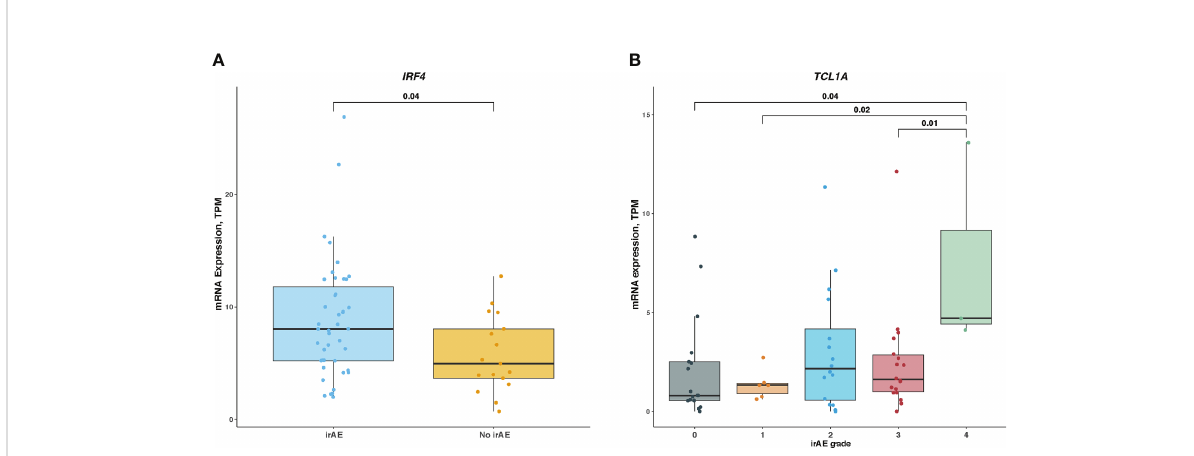
FIGURE 6 Association of IRF4 and TCL1A Expression With Immune-Related Adverse Events in ICI-Treated Melanoma Cohort (A) , Comparison of IRF4 mRNA level in irAEs-experiencing patients vs irAEs-free ones. (B) , Comparison of TCL1A mRNA level among different irAEs grades. Box plots show the median, fi rst, and third quartiles; error bars extend to 1.5 times the interquartile range; and the dots denote patients pro fi led by mRNA sequencing. The Mann-Whitney U test was used to determine signi fi cance. TPM, transcripts per